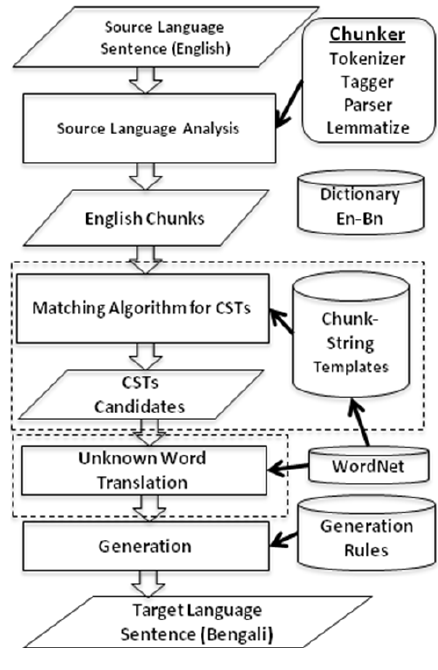
Fig. 1 Proposed EBMT System